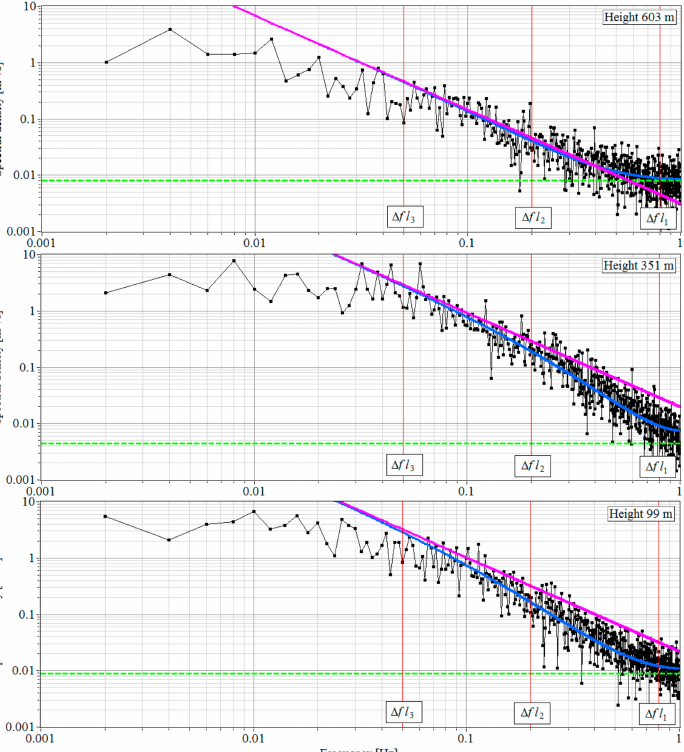
Figure 2. Experimental spectral density of the radial velocity at heights of 99 m, 351 m, and 603 m (black curves) and the noise component S N (green dashed line). Measurements from 08:42 to 09:12 local time (UTC/GMT+7) on 28 June 2020. The blue and pink curves are for calculated spectra S L ( f l ) and S K ( f l ) ,